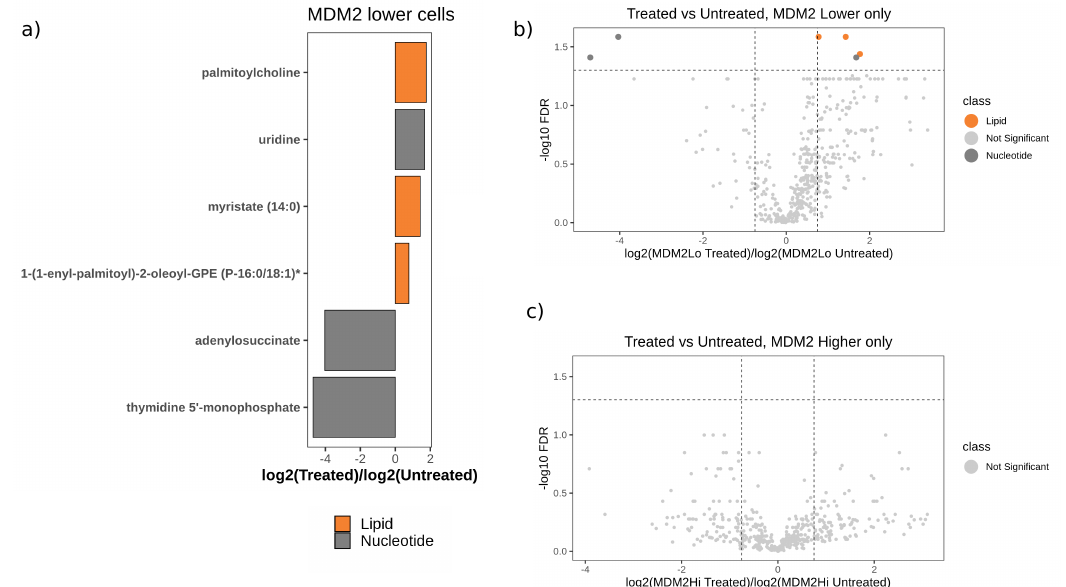
Figure 2. p53 reactivation using an MDM2 binding inhibitor causes lipid upregulation in MDM2 lower cell lines. ( a ) Metabolites altered in DDLPS MDM2 lower amplification cells that are untreated or treated with MDM2 binding inhibition (RG7112) (FDR-adjusted p -val < 0.05 and |log2 fold change| > 0.75). ( b ) Volcano plot demonstrating shifts in metabolite levels caused by MDM2 inhibitor treatment in MDM2 lower cells. ( c ) No statistically significant metabolites were identified in MDM2 higher